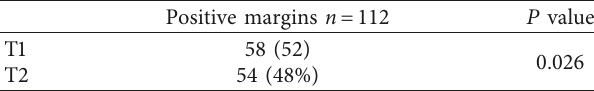
Table 2: Comparing T1 versus T2 patients with positive